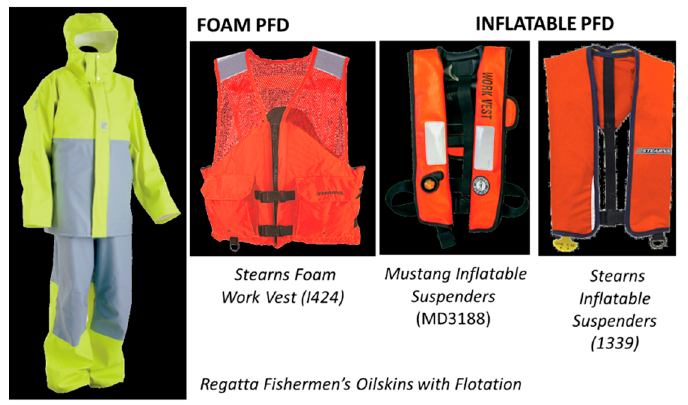
Figure 6. The four most popular PFDs evaluated by fishers across the use of five different fishing gear, 2009, adapted from NIOSH images. Open source and approval from Jennifer Lincoln, NIOSH [52].